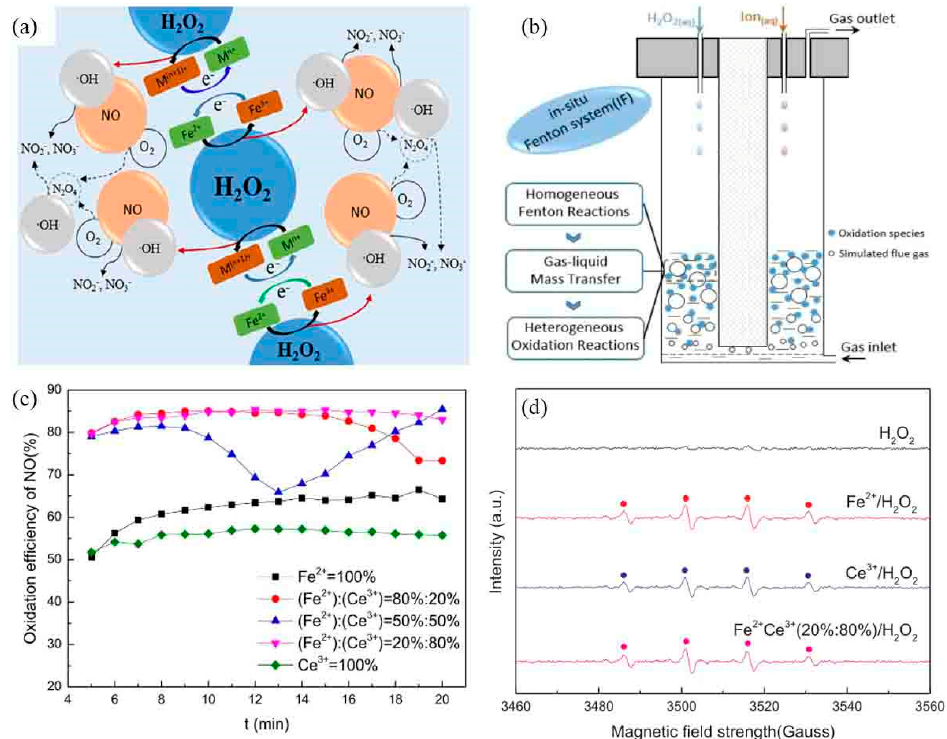
Figure 7. ( a ) Reaction mechanism of in situ Fenton system with two-ion reagents, ( b ) schematic diagram of in situ Fenton system, ( c ) effect of Ce-doping with different proportion on NO conversion, and ( d ) XRD was used to further explore the effect of Ce on the dispersion of Fe 2+ [127]. Reproduced from Ref. [127], Copyright 2018, Elsevier.